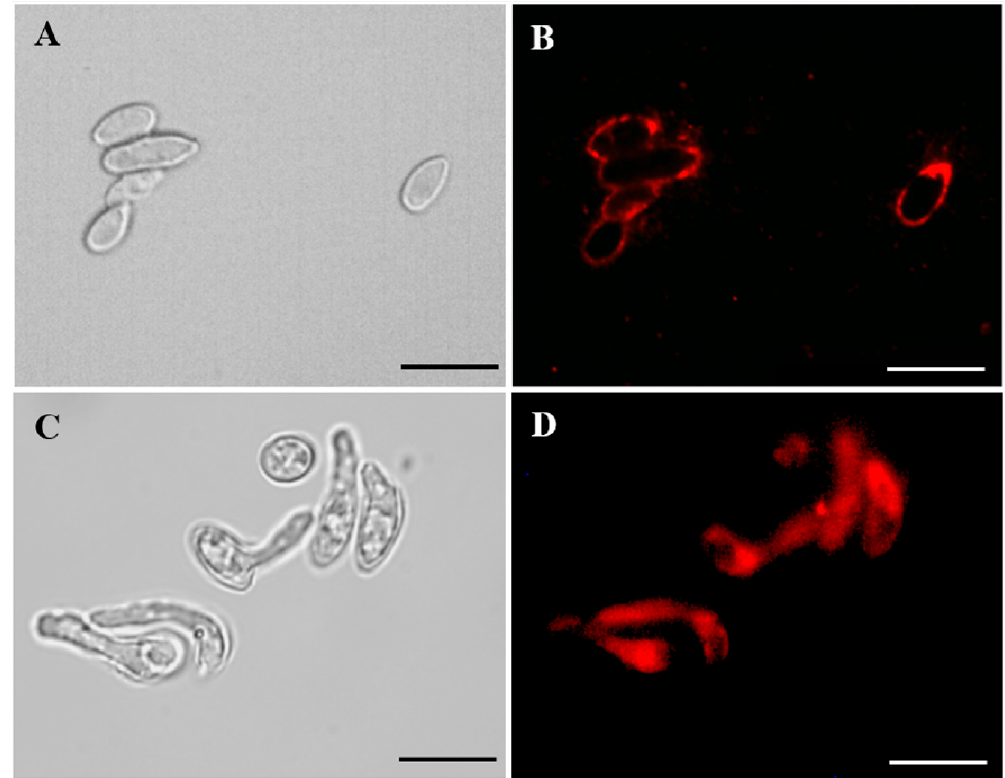
Figure 2. Indirect immunofluorescence of P. minutispora ( A , B ) and S.aurantiacum ( C , D ) conidial forms with anti-GlcCer Mab (monoclonal antibody). Differential interferential contrast microscopy (DIC) ( A and C ) and immunofluorescence ( B and D ). Scale bars: 10µm.